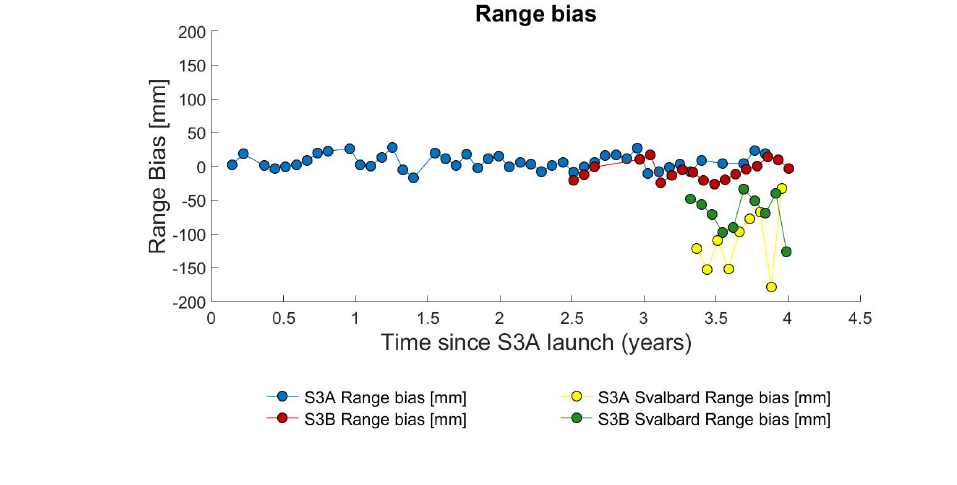
Figure 22. Range bias results.